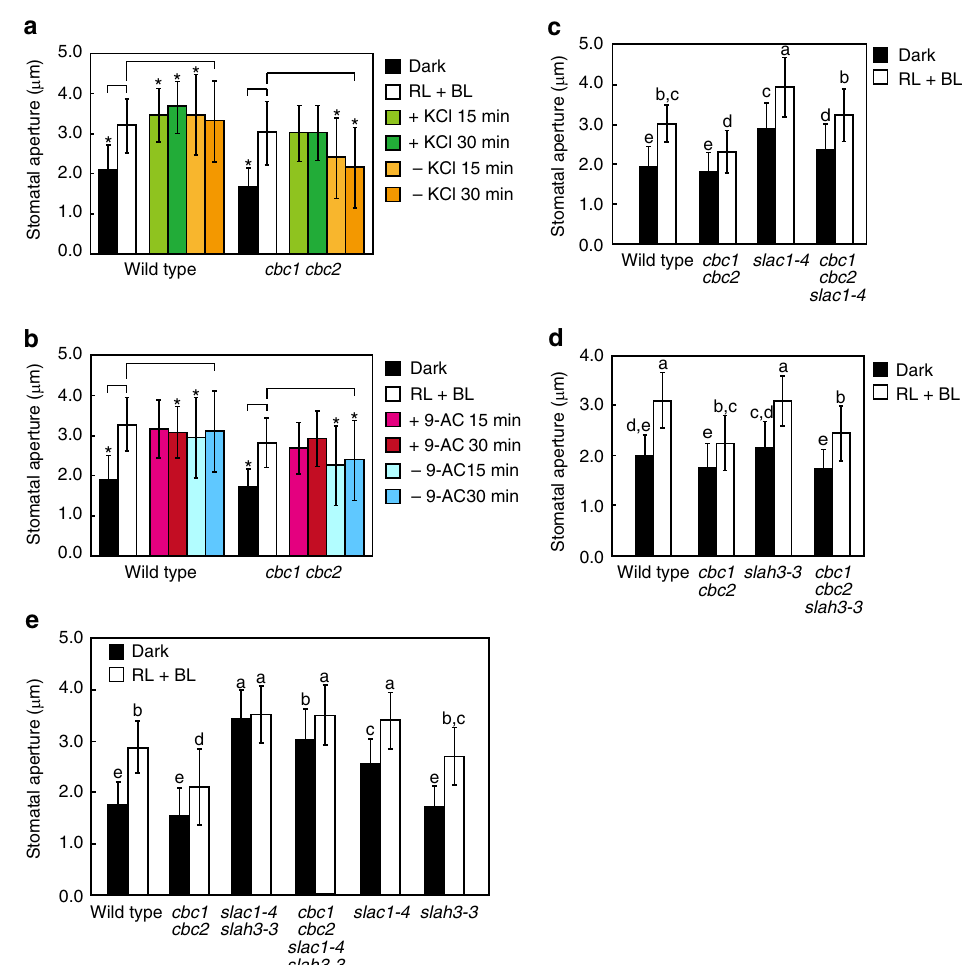
Fig. 2 Enhancement of stomatal closure in the cbc1 cbc2 mutants in the absence of KCl. a Light-induced stomatal opening in WT and cbc1 cbc2 . Epidermal peels in 5 mM MES-bistrispropane buffer (pH 6.5) containing 50 mM KCl were illuminated with RL (50 μ mol m − 2 s − 1 ) plus BL (10 μ mol m − 2 s − 1 ) for 2 h to open stomata. Stomatal apertures were measured from epidermal peels fl oating on the buffer. A portion of the peels was transferred to a buffer containing 50 mM KCl or no KCl and held for 15 or 30 min in the light; epidermal peels were left fl oating on the same buffer for measurement of stomatal apertures. Asterisks denote the signi fi cant differences in stomatal apertures in comparison with WT or cbc1 cbc2 double mutants treated with RL + BL. * P < 0.05 by Student ’ s t test. b Inhibition of stomatal closure by anthracene-9-carboxylic acid (9-AC) in the absence of KCl. Once stomata were allowed to open as described in a , then epidermal peels were transferred to a KCl-free buffer containing 100 μ M 9-AC. c , d , e Light-induced stomatal opening in WT, cbc1 cbc2 , slac1 , and slah3 , their triple ( cbc1 cbc2 slac1-4 and cbc1 cbc2 slah3-3 ) and quadruple ( cbc1 cbc2 slac1-4 slah3-3 ) mutants. Signi fi cant differences are denoted with different lowercase letters and analyzed by ANOVA tests followed by a post hoc Tukey test. Stomatal apertures were measured for 25 stomata from fl oating epidermal peels, and the experiments were repeated three times in different occasions. Bars represent means ± s.d. ( n = 75, pooled from